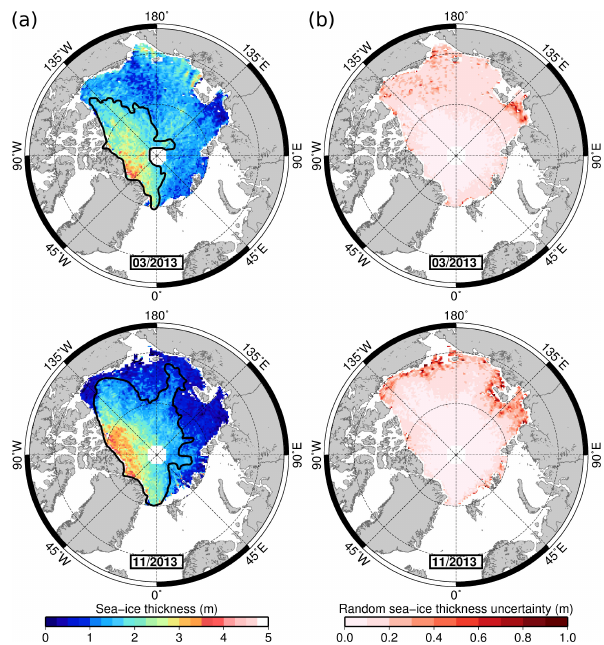
Figure 11. Range differences between different TFMRA (threshold first-maximum retracker algorithm) retracker thresholds for March (upper row) and November (lower row) 2013. (a) TFMRA40– TFMRA50, (b) TFMRA40–TFMRA80. The black polygon defines the averaged MYI zone, retrieved from the OSI SAF ice-type prod- uct.